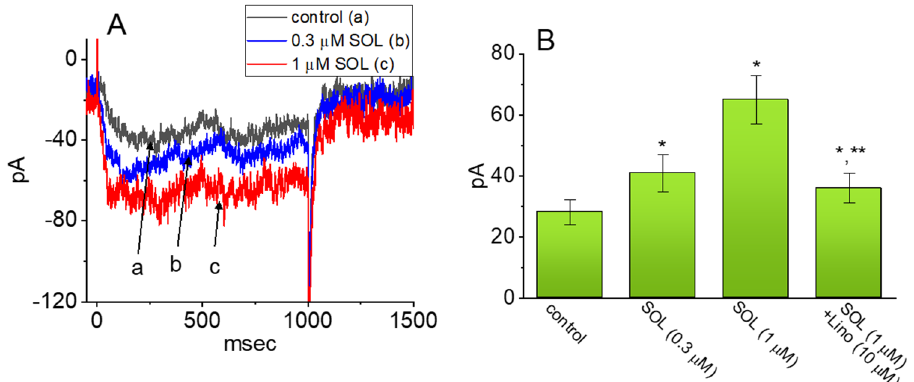
Figure 9. Stimulatory effect of SOL on I K(M) recorded from mouse hippocampal mHippoE-14 neurons. In this set of whole-cell voltage-clamp experiments, cells were bathed in high-K + , Ca 2+ -free solution, the recording pipette used was filled up with a K + -enriched (145 mM) solution, and the examined cells were depolarized from − 50 to − 10 mV with a duration of 1 sec. ( A ) Representative current traces obtained in the control period (a) and in the presence of 0.3 μM SOL (b) or 1 μM SOL (c). ( B ) Summary bar graph showing effect of SOL and SOL plus linopirdine (Lino) on the amplitude of I K(M) in mHippoE-14 cells (mean ± SEM; n = 7 for each bar). Current amplitude was measured at the end-point of the depolarizing command from −50 to −10 mV. Data analysis was performed by ANOVA-1 ( P < 0.05). * Significantly different from control ( P < 0.05) and ** significantly different from SOL (1 μM) alone group ( P < 0.05). Of notice, the presence of SOL exercises a stimulatory effect on I K(M) , and subsequent addition of linopirdine attenuates SOL-mediated stimulation of current amplitude.